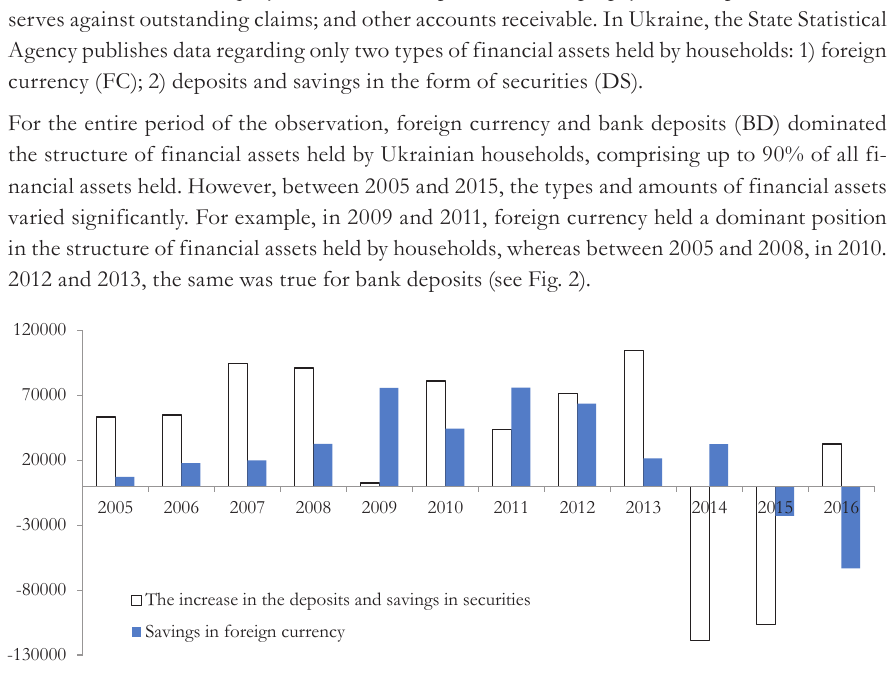
Fig. 2 – Dynamics of the amounts of the main types of financial assets held by Ukrainian households in 2005- 2016. Source: own